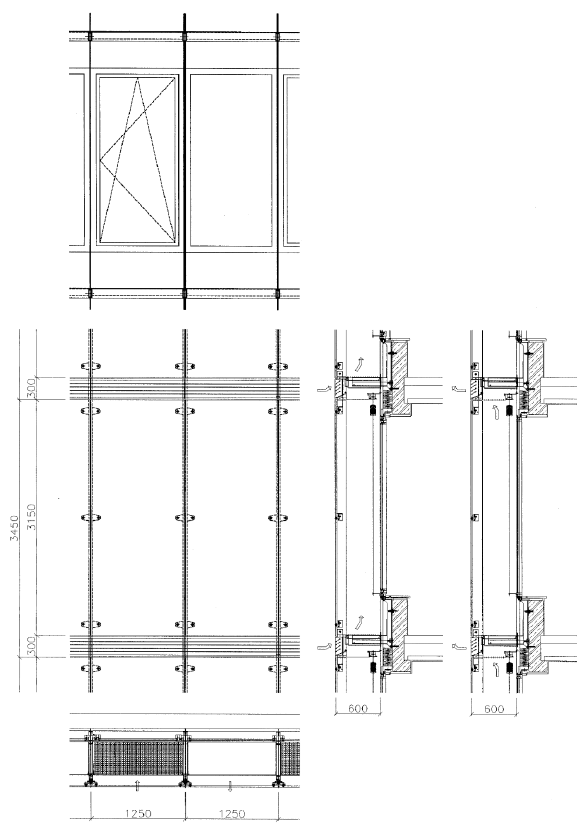
– kinematic viscosity coefficient of air ν (m 2 /s). Coefficients of local resistances along the height of the moving line of the air flow of the double skim facade – Figure 5, is determined